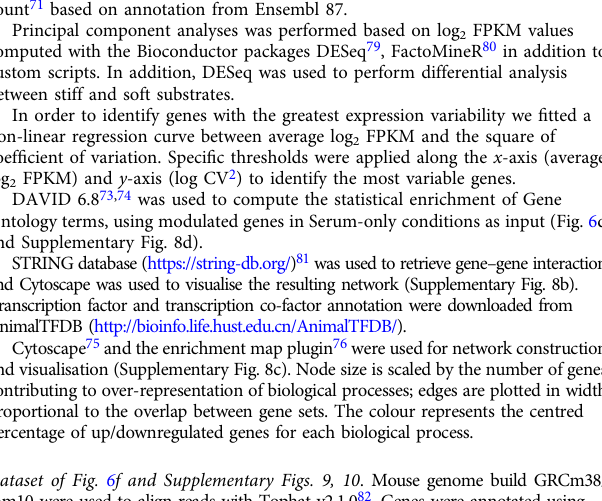
Dataset of Fig. 6f and Supplementary Figs. 9, 10 . Mouse genome build GRCm38/ mm10 were used to align reads with Tophat v2.1.0 82 . Genes were annotated using Ensembl release 86 78 and read counts were quanti fi ed using Featurecount v1.5.0 83 . Differential expression analysis was computed using DESeq2 72 on protein coding genes.